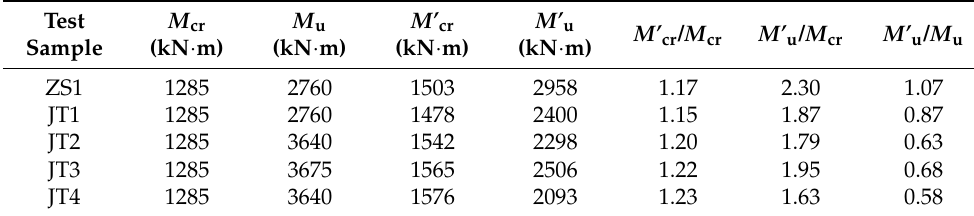
Table 3. Bending test results of PRC pipe piles and